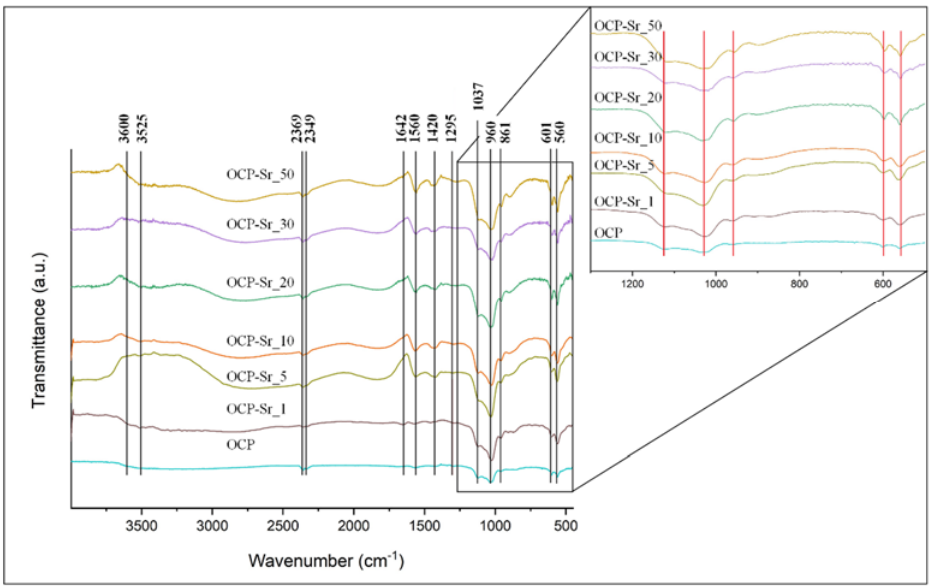
Figure 2. IR-spectra of samples OCP and Figure 2. IR - spectra of samples OCP and Sr-OCP.